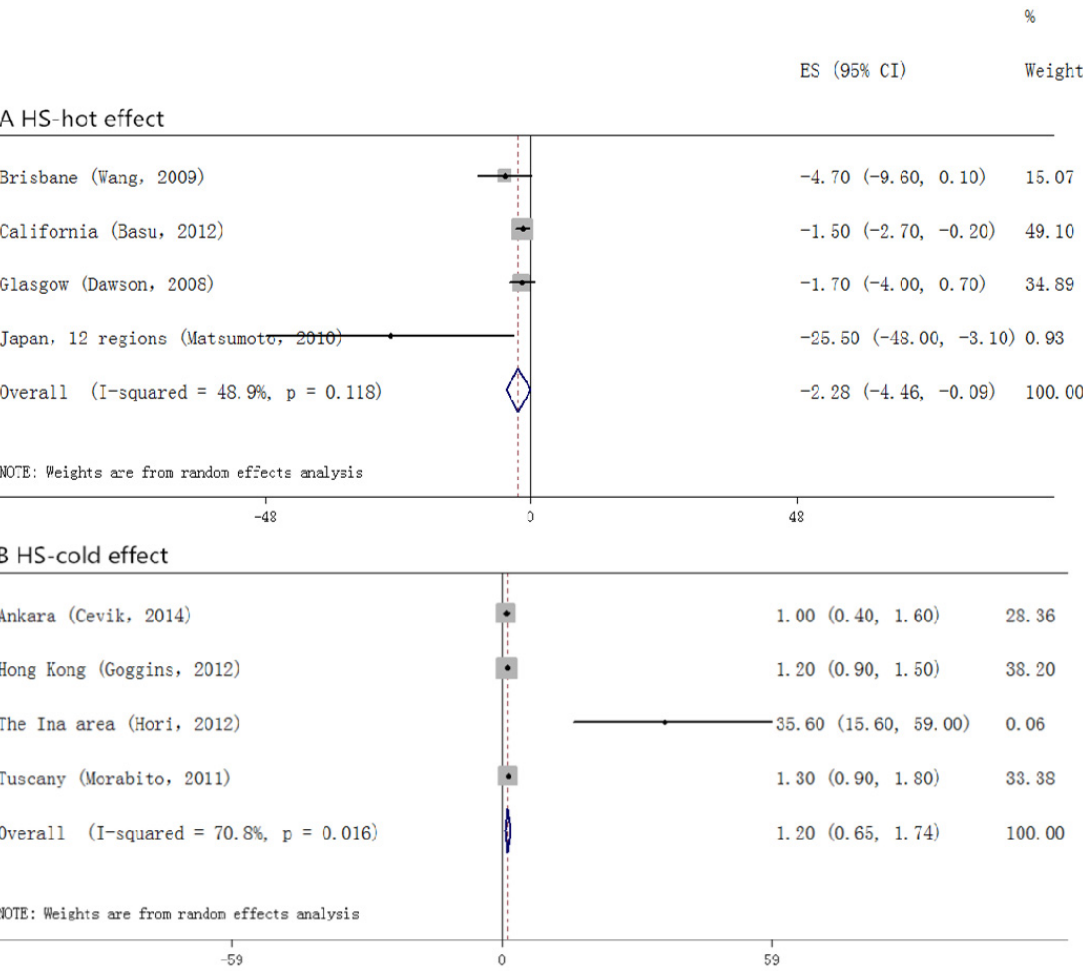
Figure 5. Forrest plots for relationship between the temperature change and HS. A and B stand for hot and cold effect,